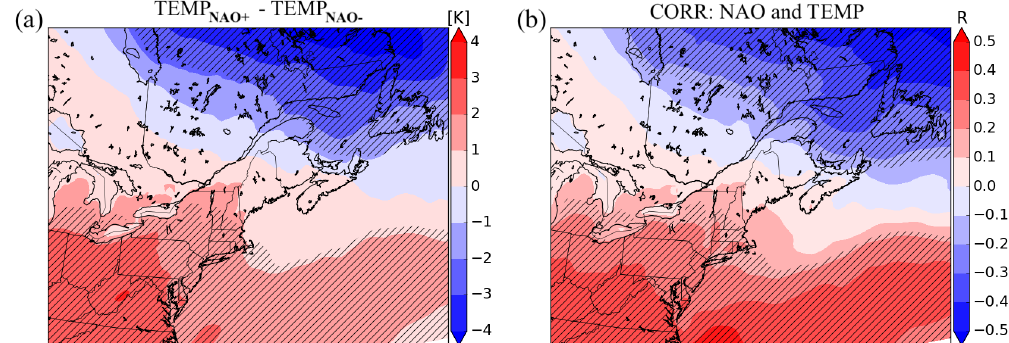
Figure 6. (a) Difference between average temperature during positive NAO and negative NAO months (40-month composites, first and fourth quartiles) in winter (DJFM); positive values mean warmer temperatures during high NAO. (b) Correlation coefficients between monthly temperature and monthly NAOI. Hatched areas represent statistically significant values at the 0.05 level.